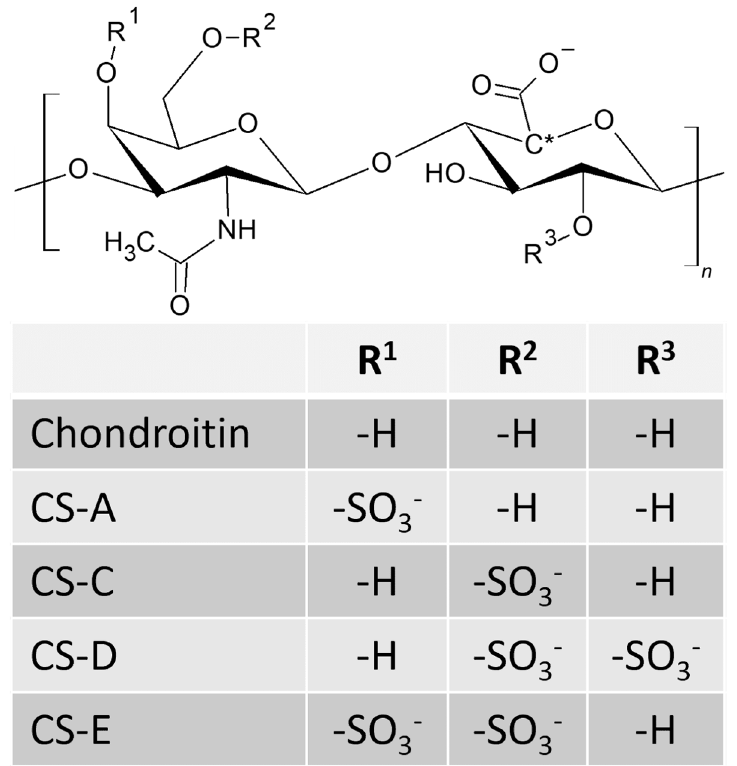
Figure 1. Structures of common natural sulfation patterns. In dermatan sulfate (DS or CS-B), the stereochemistry of the carbon marked C* is inverted.